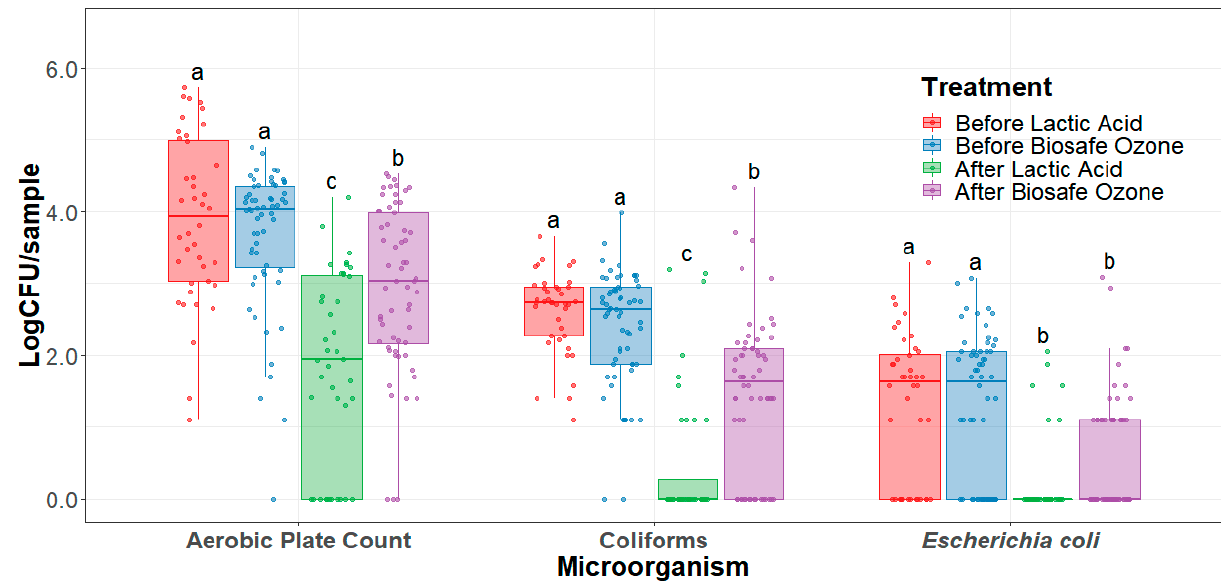
Figure 2. Trim aerobic plate count, coliforms, and Escherichia coli counts (limit of detection < 0.05 CFU/cm 2 ) before and after the application of the interventions (Log CFU/sample). Horizontal line within the boxplot represents the median. The box upper and lower limit represents the interquartile range, and the bars represent 1.5xInterquartile Range. a,b Box plots with different letters within the same microorganism type represent statistical differences ( p < 0.05).